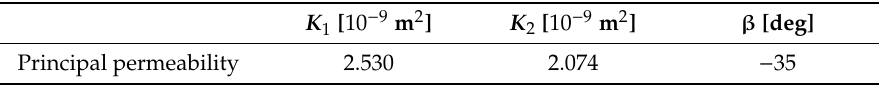
Table 5. Principal permeabilities of the glass